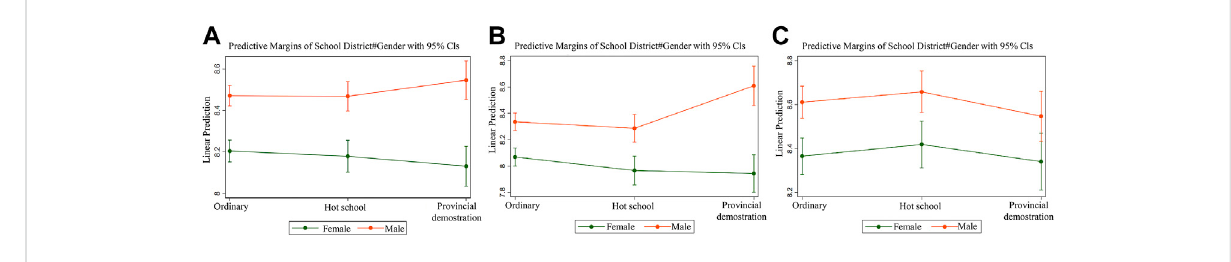
FIGURE 2 (A) Gender difference in the commuting distance of all respondents, (B) Gender difference in the commuting distance of respondents without college degrees; (C) Gender difference in the commuting distance of respondents with college degrees.